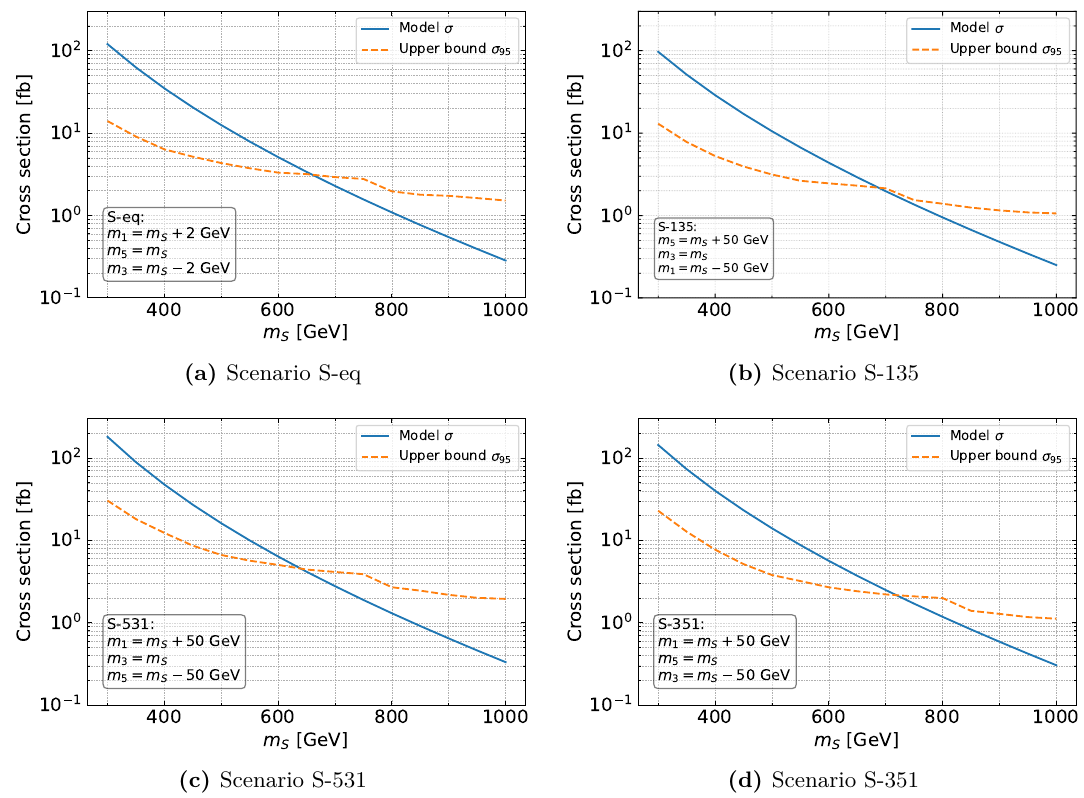
Figure 8. Bounds on the pNGB masses for the Drell-Yan production of the full bi-triplet for multiple benchmark mass spectra defined in eq. (3.12). In (a), all masses are approximately equal. In the remaining panels, there is a 50 GeV mass split between the